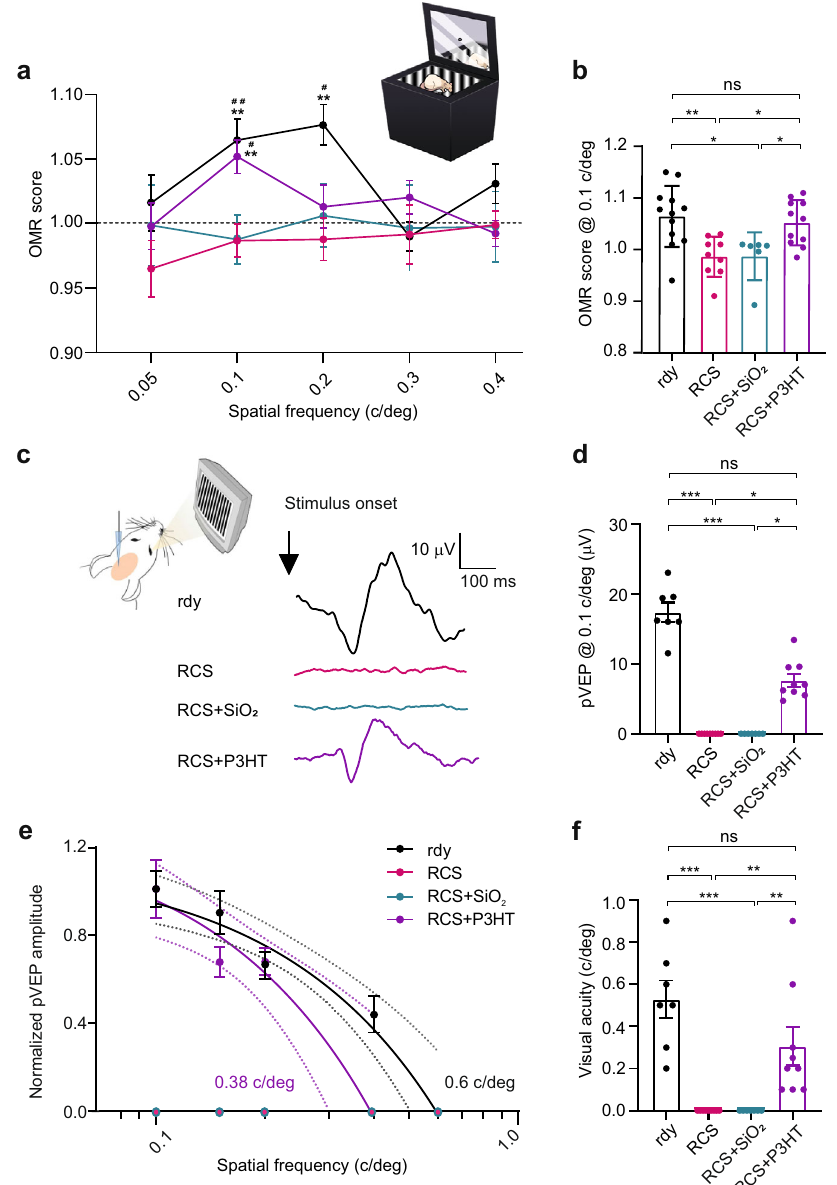
Fig. 7 Partial restoration of visual acuity in old dystrophic RCS rats injected with P3HT-NPs. a Optomotor response (OMR) apparatus to measure visual acuity (inset). The OMR score at the various spatial frequencies was measured at 30 DPI. The dashed line represents the cutoff of animals that did not react to a given spatial frequency. Healthy 11-month-old rdy rats displayed signi fi cant OMRs at frequencies between 0.1 and 0.2 c/deg, while age-matched, untreated and SiO 2 -injected RCS rats did not react to the moving patterns in the 0.05 – 0.4 c/deg range. On the contrary, P3HT-NP injected RCS rats displayed positive responses in the 0.1 – 0.3 c/deg range that became signi fi cantly different from either untreated or SiO 2 -injected rats at 0.1 c/deg. ** p < 0.01 vs untreated RCS; # p < 0.05, ## p < 0.01 vs RCS + SiO 2 ; two-way ANOVA/Fisher ’ s test. b Average OMR scores at 0.1 c/deg. P3HT-NPs injected RCS rats show no signi fi cant difference with respect to untreated rdy controls. One-way ANOVA/Holm-Sidak ’ s test. a , b Sample size: n = 12, 9, 6 and 11 for rdy, RCS, RCS + SiO 2 and RCS + P3HT, respectively. c Left: Experimental setup for VEP recordings in the binocular portion of V1 (Oc1b) in response to patterned stimuli (pVEP; 120 cd/m 2 , 100 ms, 1 Hz; spatial frequency range: 0.01 – 0.6 c/deg). Right : representative pVEP traces recorded in 13/15-month-old healthy rdy rats (rdy), untreated RCS rats, and RCS rats injected with either SiO 2 -NPs (RCS + SiO 2 ) or P3HT-NPs (RCS + P3HT). d VEP amplitude in Kruskal – Wallis/Dunn ’ s Tests. e , f Analysis of the pVEP amplitude, normalized to the response to 0.1 c/deg stimuli ( e ), and mean visual acuity,